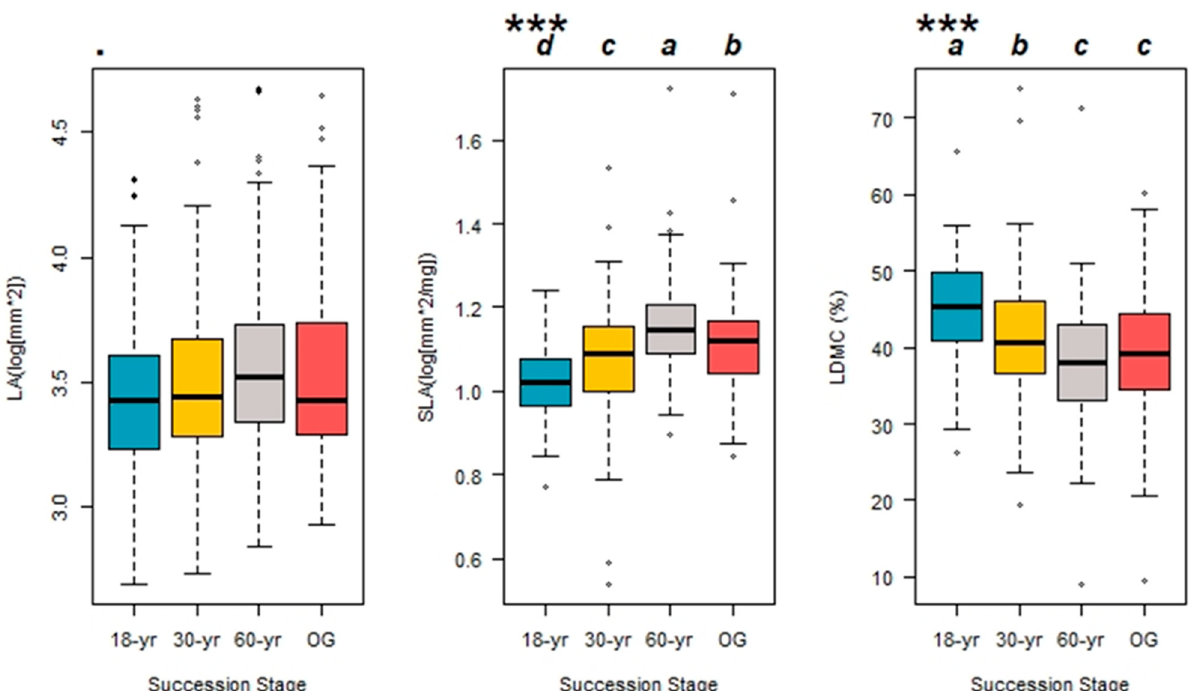
Figure 1. Changes of functional traits of co-existing tree species in different succession stages of tropical lowland rain forests in Hainan. Where LA is leaf area, SLA is specific leaf area, and LDMC is dry matter content of leaves. (Blue, 18-year-old forest; yellow, 30-year-old forest; gray, 60-year-old forest; red, old-growth forest.) One-way ANOVA test, p > 0.05 indicates non-significant difference among different stages, ***, p < 0.001 indicates the significant difference. A post hoc Tukey test was performed to test difference of combinations of functional traits: different letters indicated significant differences among the succession stages ( p < 0.05).